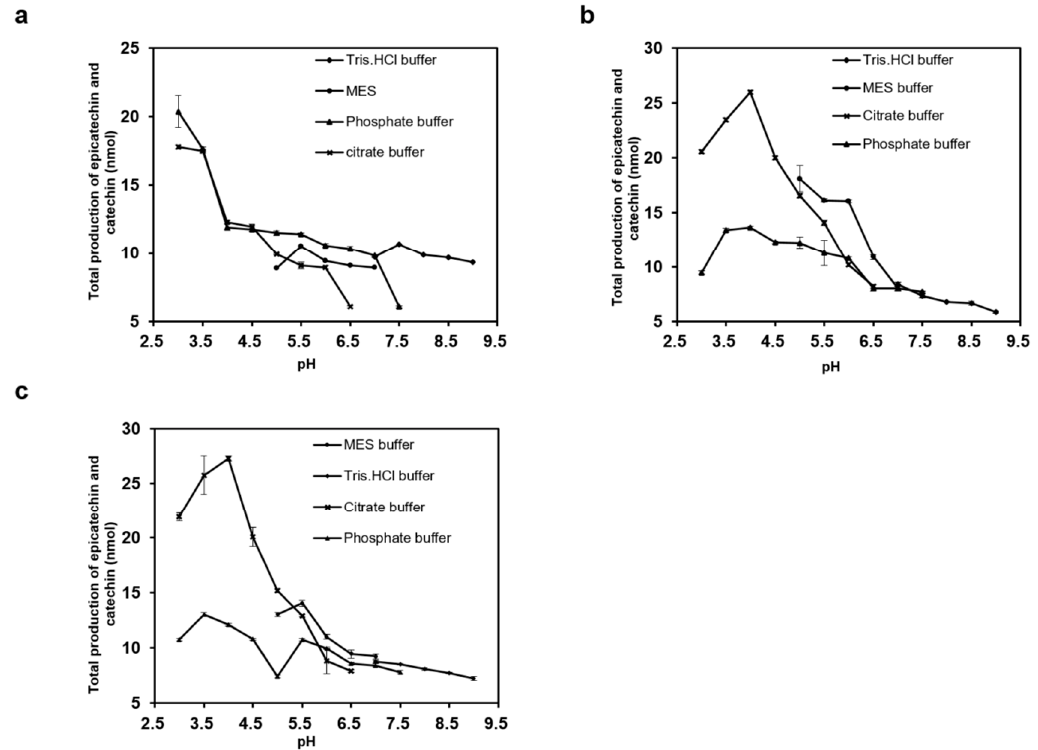
Figure 5. Effects of pH values on MiANR1-1, 1-2 and 1-3 activity. ( a ) pH effect on MiANR 1-1 activity